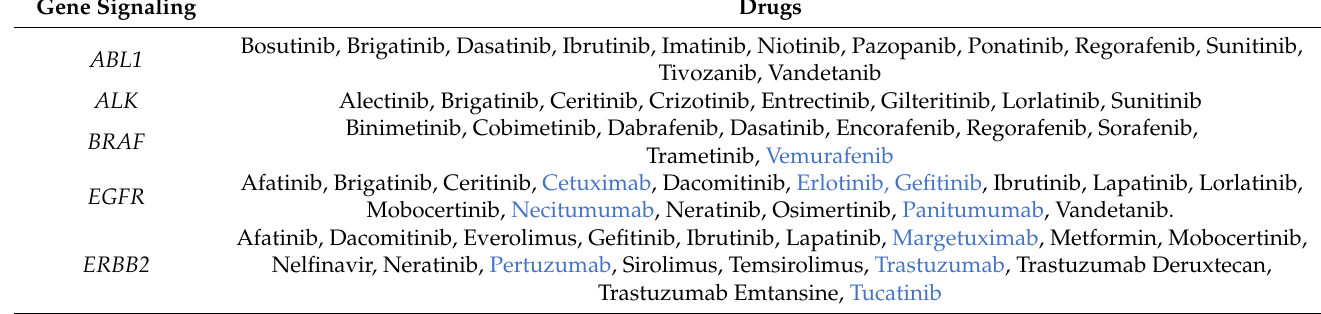
Table 1. FDA approved drugs targeting the signaling of 18 cancer-related genes of the RTK-RAS pathway. Drugs that specifically target only the corresponding gene are shown in blue color. Drugs granted with a Breakthrough Therapy Designation but not yet approved by the FDA, are not included in this